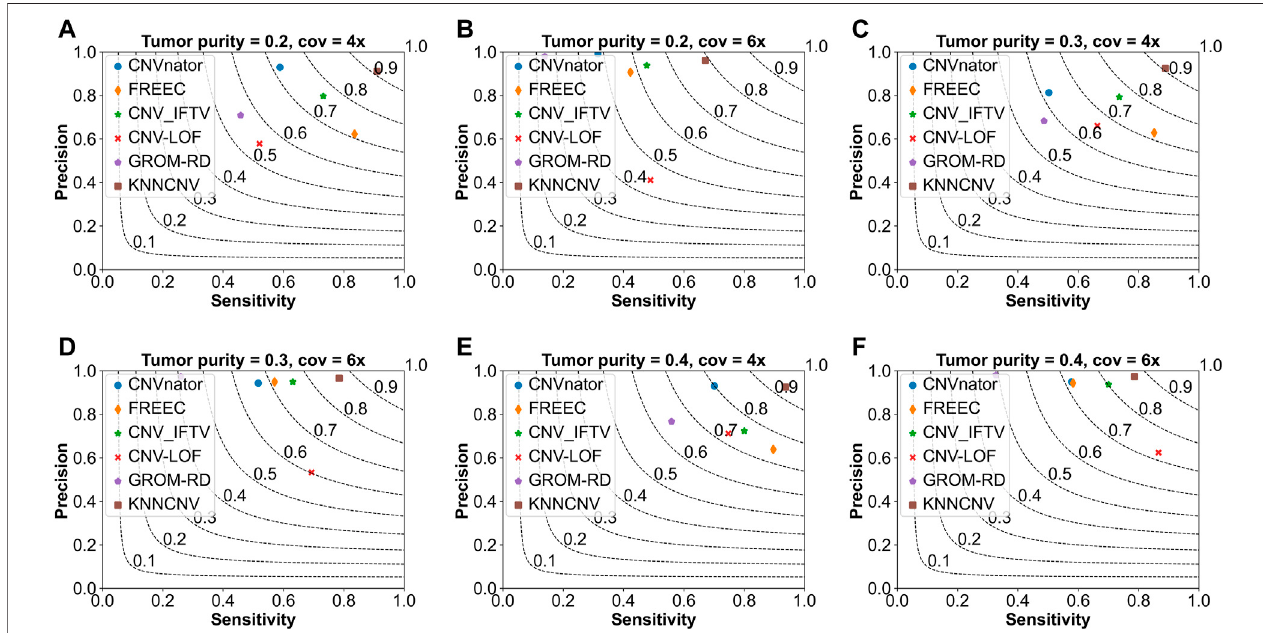
FIGURE2| ComparisonoftheKNNCNVwith fi vepeermethodsonthesimulateddatasetsintermsofprecision,sensitivity,andF1-score.TheF1-scoreisshownin black dashed lines ranging from 0.1 to 0.9 with an increment of 0.1. (A – F) They show the performance of the above six methods on different simulated con fi gurations,